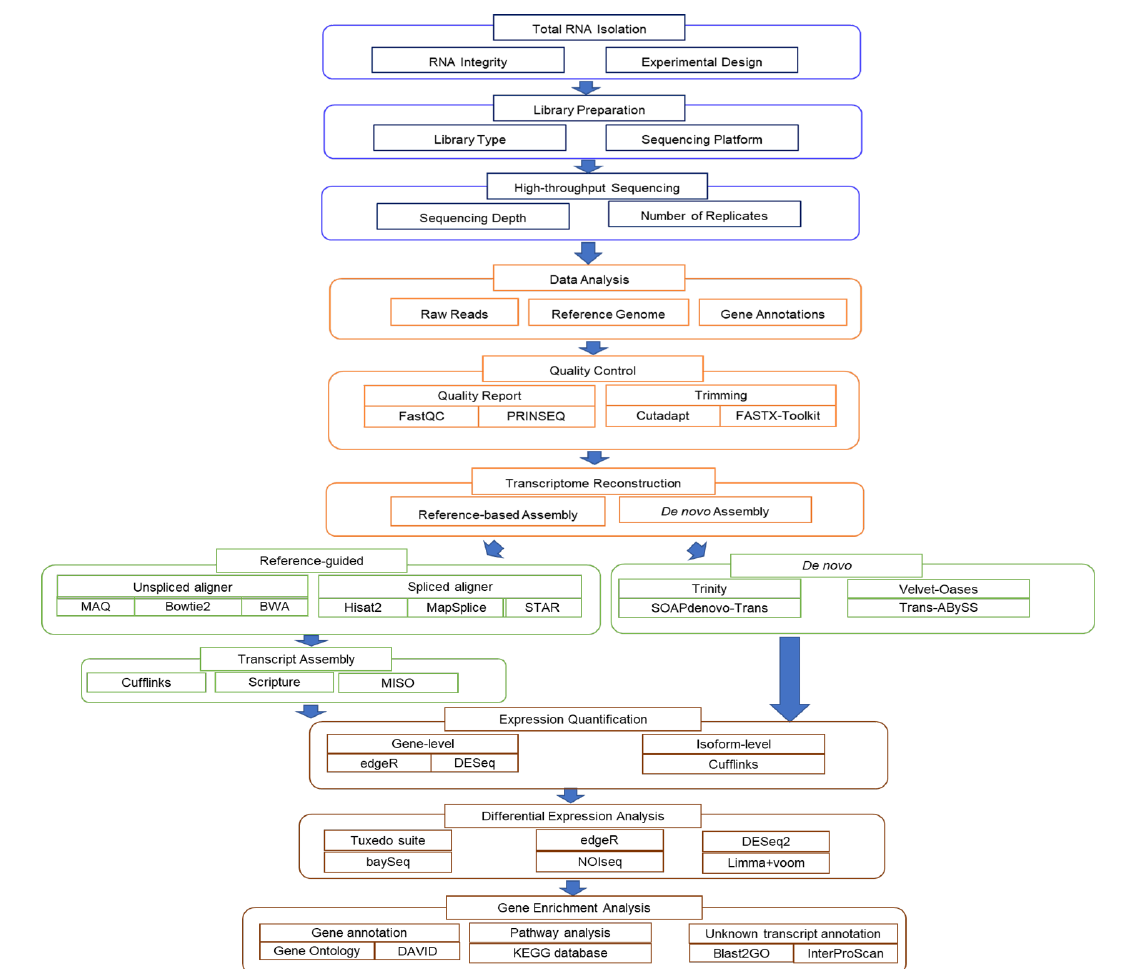
Figure 1. General RNA-seq analysis pipeline. The workflow typically starts with total RNA